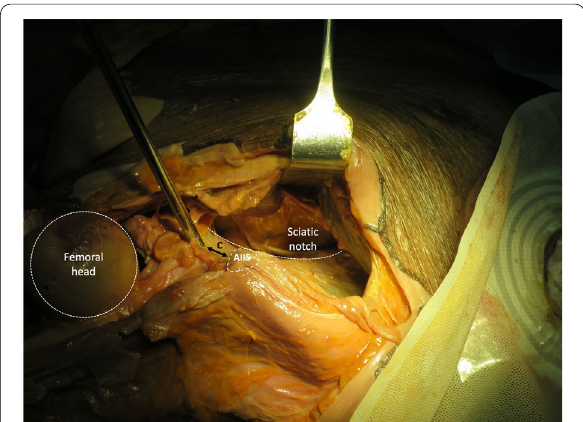
Fig. 7 The greater sciatic notch and internal cortex of the ilium are exposed to visualize pin penetration on the left hemipelvis, and the distance ( c ) from the pin to the anterior inferior iliac spine (AIIS)